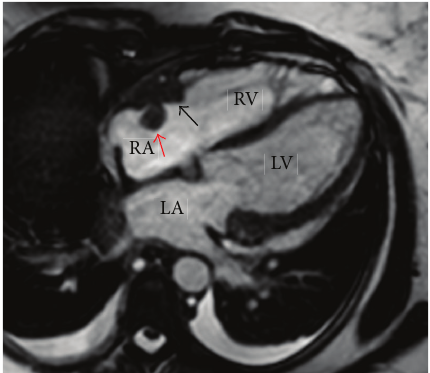
Figure 2: Steady-state free precession magnetic resonance image demonstrating a broad based, isointense structure (black arrow) measuring 3cm × 1cm arising from the lateral wall of the right atrium adjacent to the atrioventricular junction of the right atrium. Connected to this broad based mass is an isodense, circular, well-circumscribed mass (red arrow) measuring 1cm in diameter protruding from the broad based mass into the right atrium. RA: right atrium, RV: right ventricle, LA: left atrium, LV: left